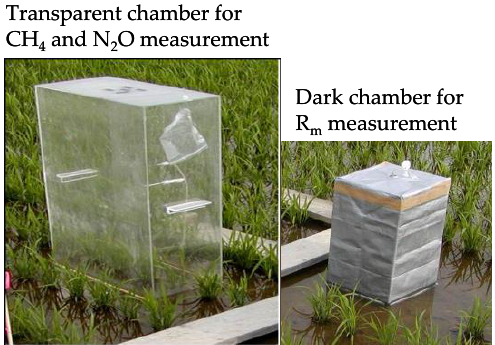
Figure 1. Placement of chambers and building of boardwalks at each sampling site.